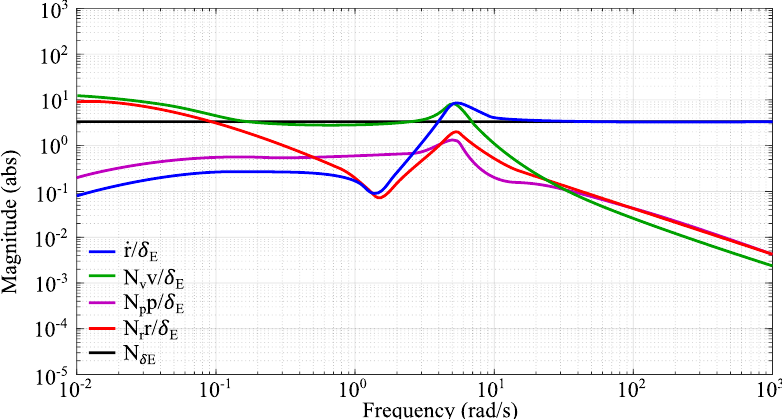
Figure 4. Bode plot for yawing moment derivatives due to elevator